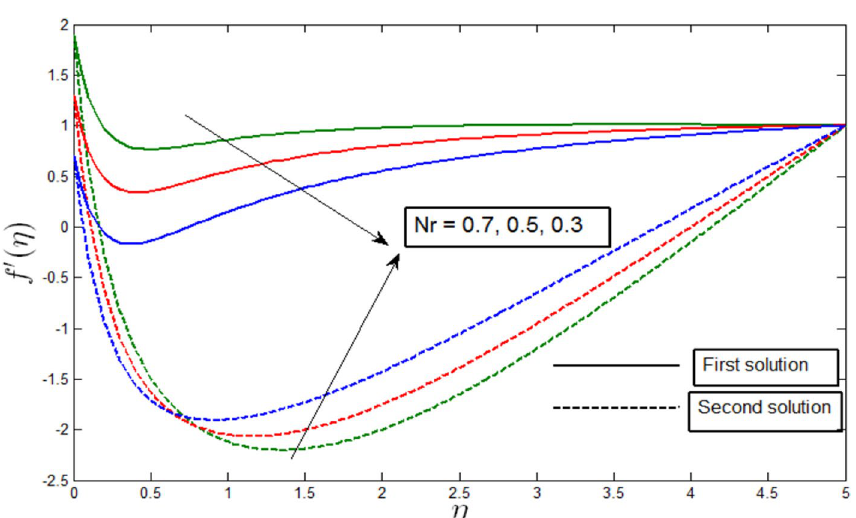
′ (η) Figure 3. Velocity profile f for various Nr when (cid:31) = − 3, γ = 5, Lb = 0.5, Le = 0.5, Pb = 0.5, Rb = 0.6, A =